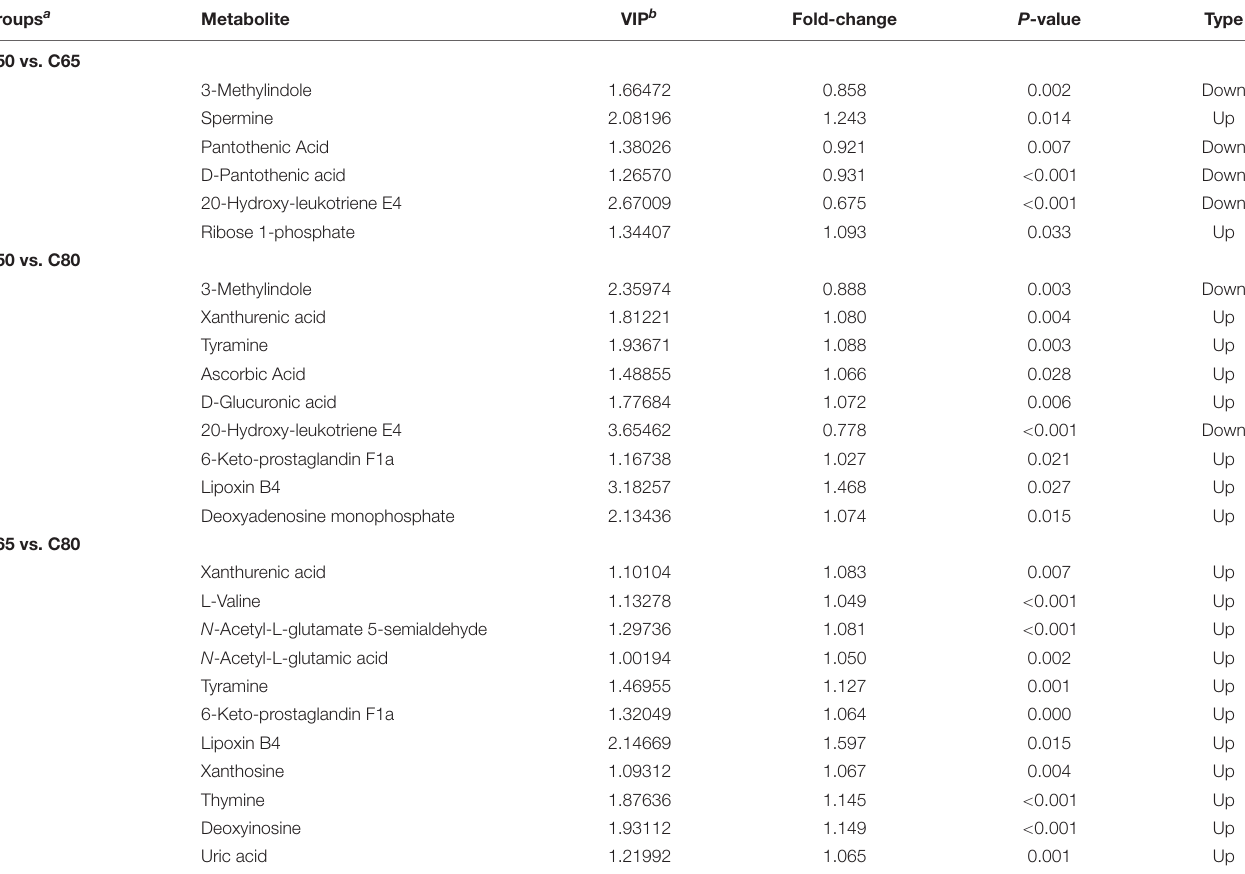
TABLE 2 | Main differential metabolites involved in different metabolic pathways between the three groups. Groups